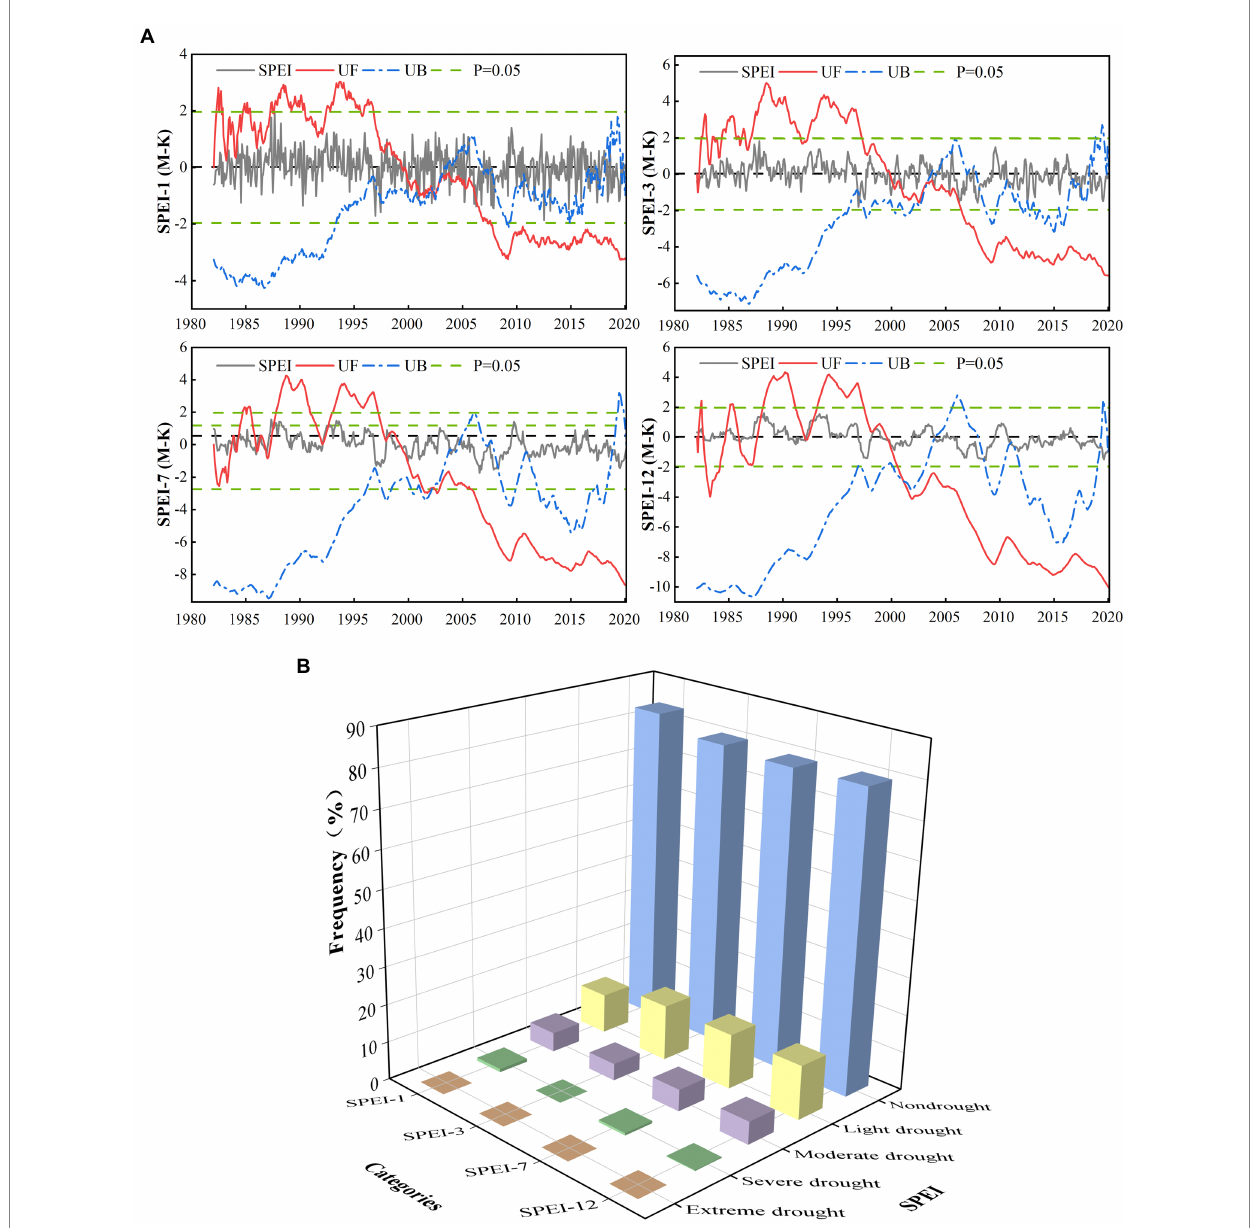
FIGURE 5 (A) Time series and Mann-Kendall tests of SPEI at different scales from 1982 to 2020. (B) Frequency of different drought grades at different scales from 1982 to